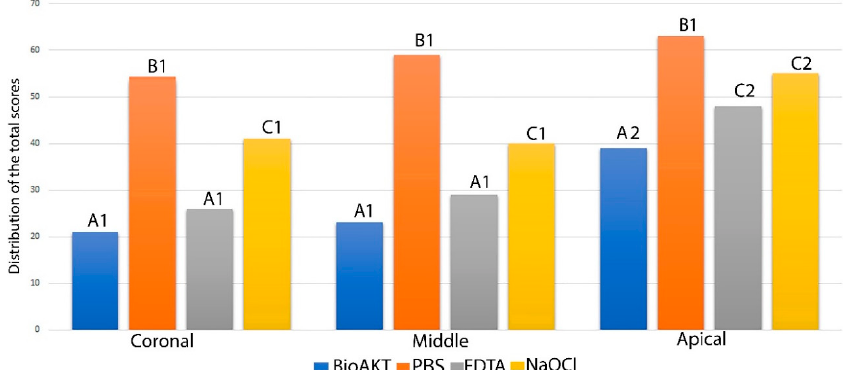
Figure 1. Graph showing the quantitative total distribution of the scores for smear layer removal (score 0–4) obtained during the SEM evaluation for each treatment at different root canal level. Please note that the lower the total value the greater the ability to remove smear layer. Similar letter indicates no significance between the irrigants in each third level of the root. Similar number indicates no significance between the same irrigant in different third level.